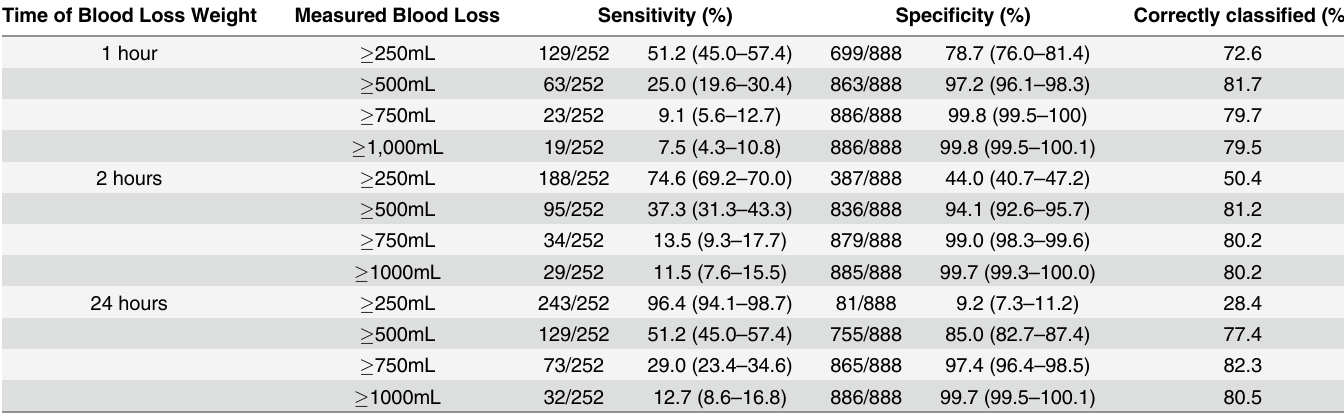
Table 3. Sensitivity and specificity of blood loss measurement by weight method at Varying time points and volumes of blood loss, compared to reference standard of > 10% drop in haemoglobin.